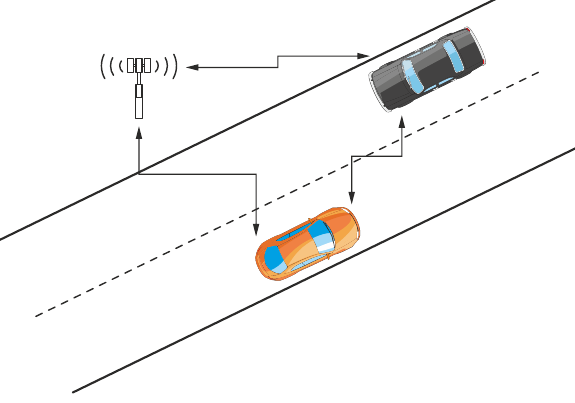
Figure 1. V2V and V2R